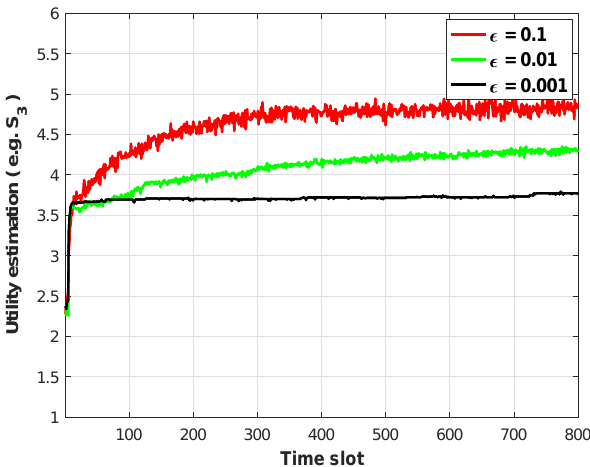
Figure 3. Influence of parameter (cid:101) on the convergence of softmax-greedy action selection strategy.